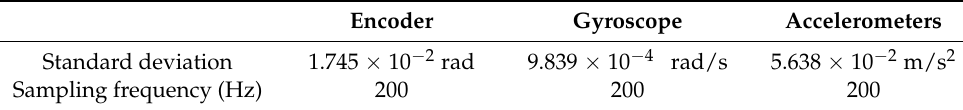
Table 3. Characteristics of the sensors considered in this